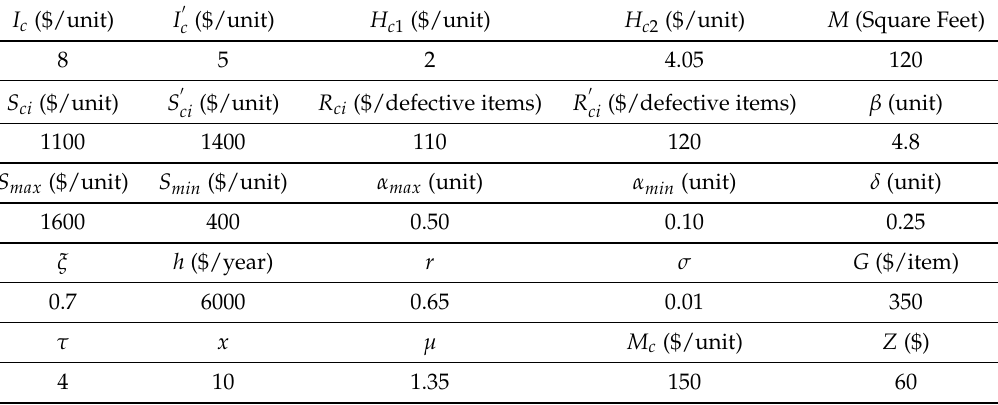
Table 6. Input parameters of Example